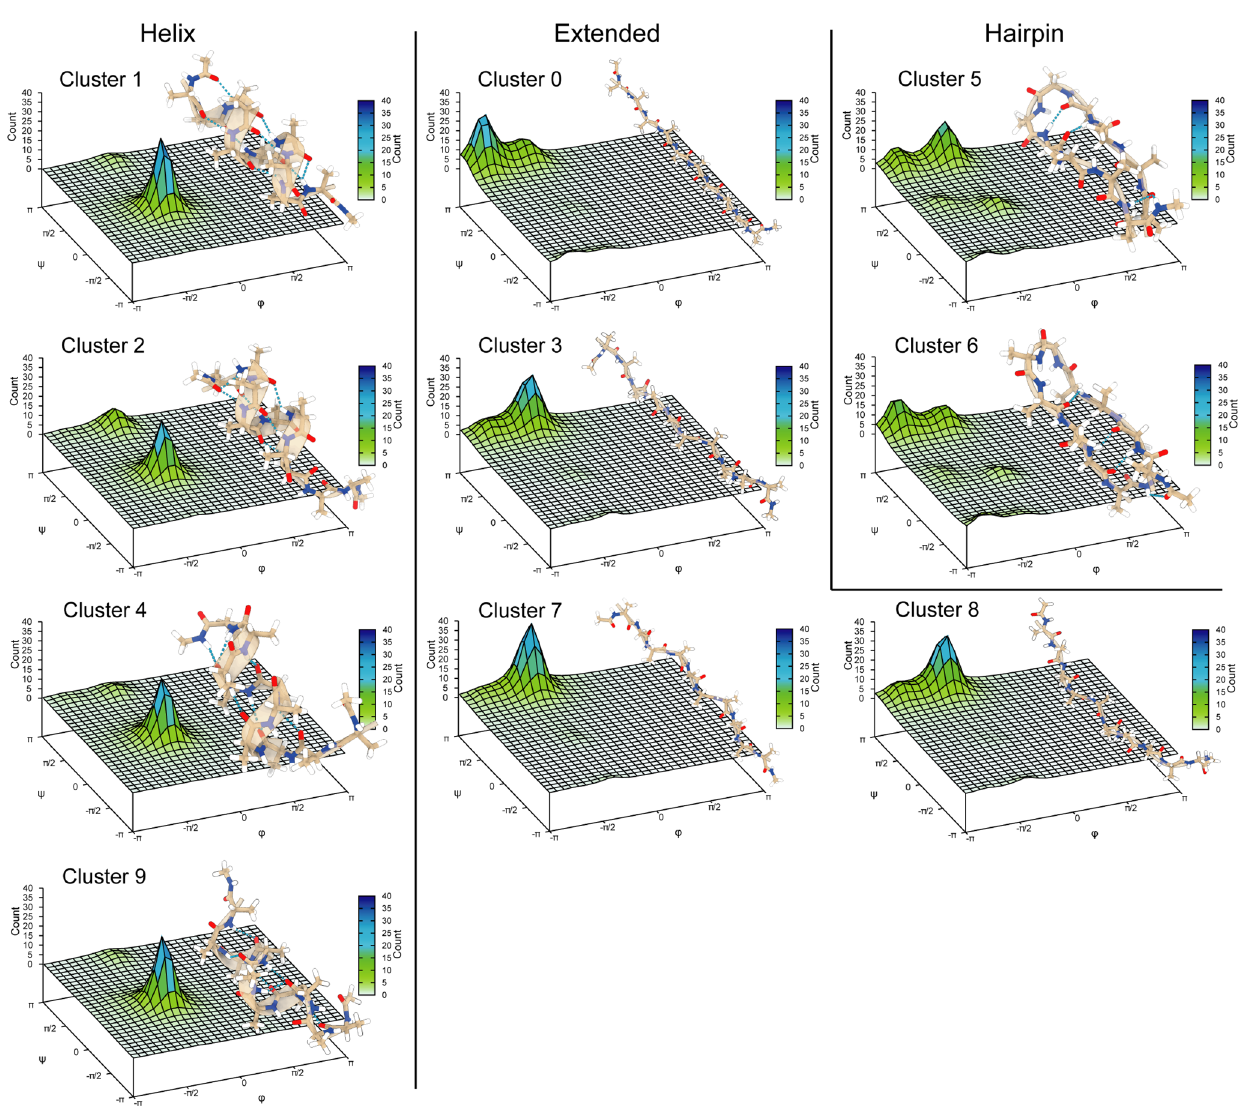
Fig. 7 Ramachandran plot for a distribution of 1000 structures per cluster, which have been divided with respect to their family. A structural representation is also offered to show the different conformations of